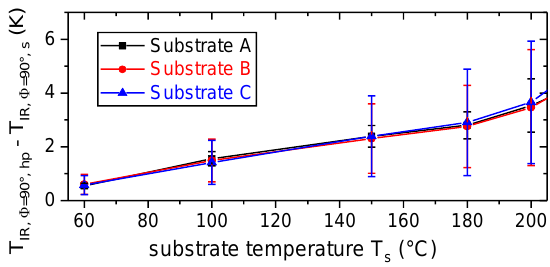
Figure 7. Thermographic determined difference in surface temperature between the hot plate (T IR,Φ=90°, hp ) and the substrates (T IR,Φ=90°, s ) mounted on the hot plate (cf. Figure 2).